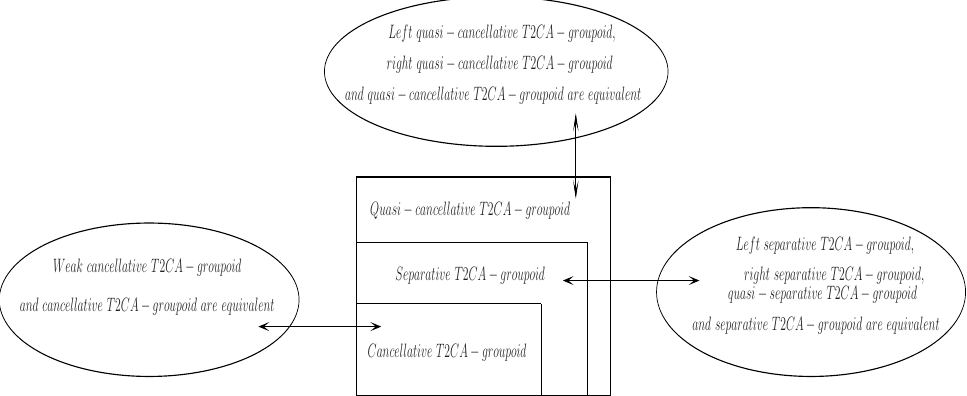
Figure 5. The main results obtained for the T2CA-groupoid in this